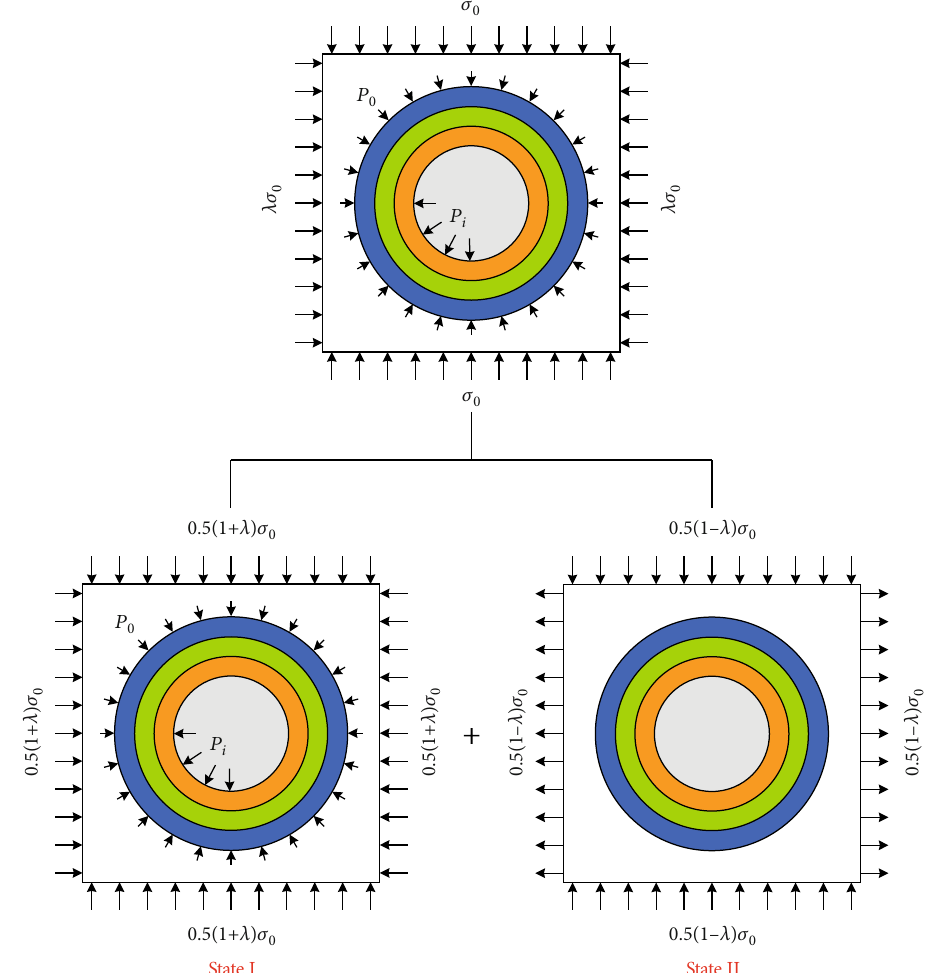
Figure 3: Mechanical model of surrounding rock in water-rich coal